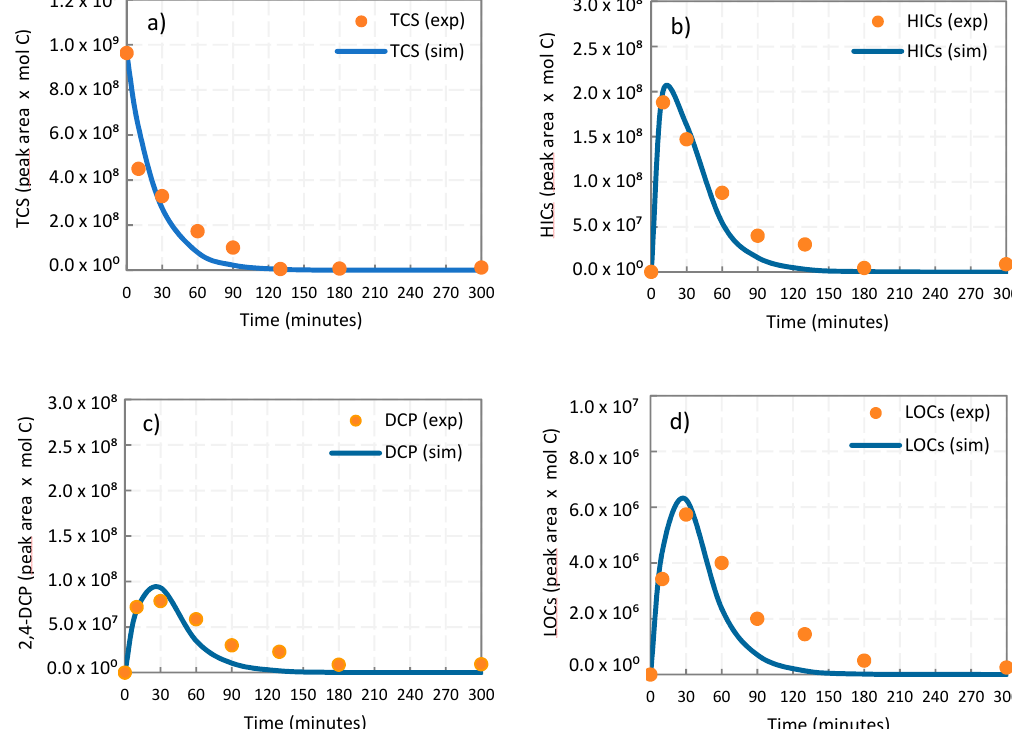
Figure 6. Fitting of simulated and experimental data of ( a ) TCS photocatalysis, ( b ) higher concentration derivatives (HICs), ( c ) 2,4-dichlorophenol (DCP) and ( d ) lower concentration derivatives